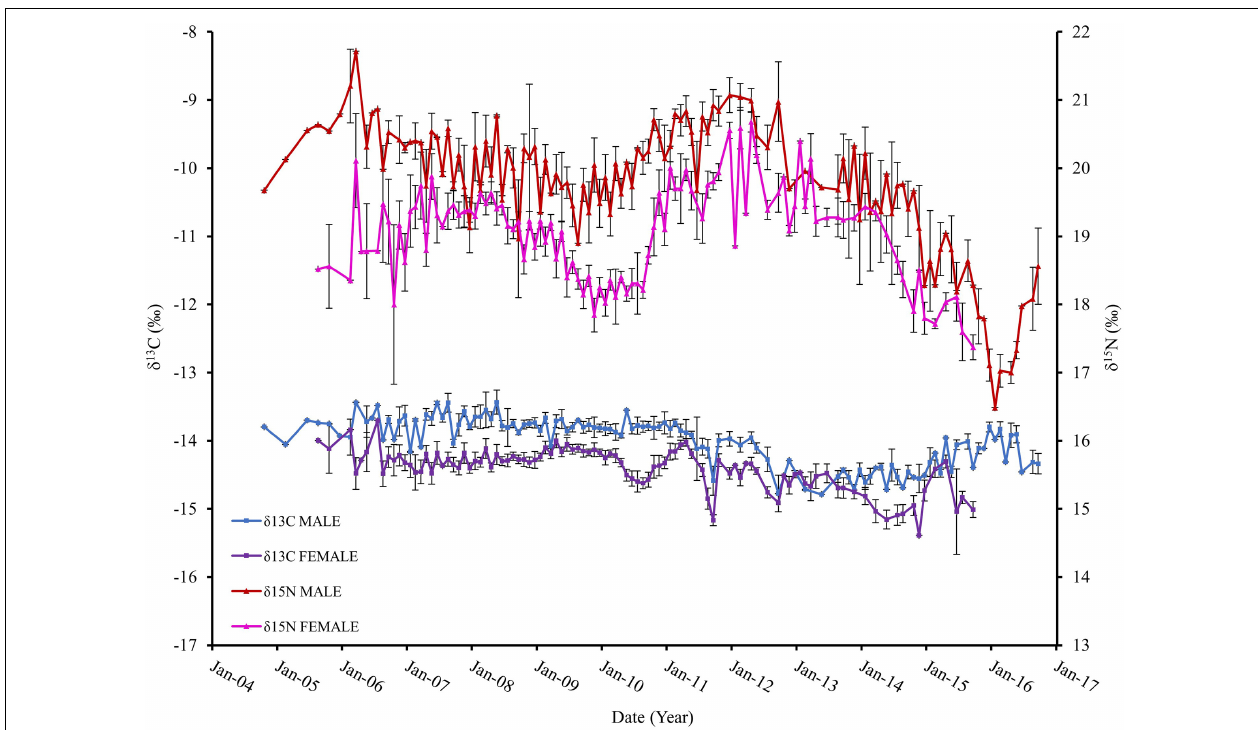
), 2004–2016. Female δ 13 C is purple and δ 15 N is pink, while male (cid:104)